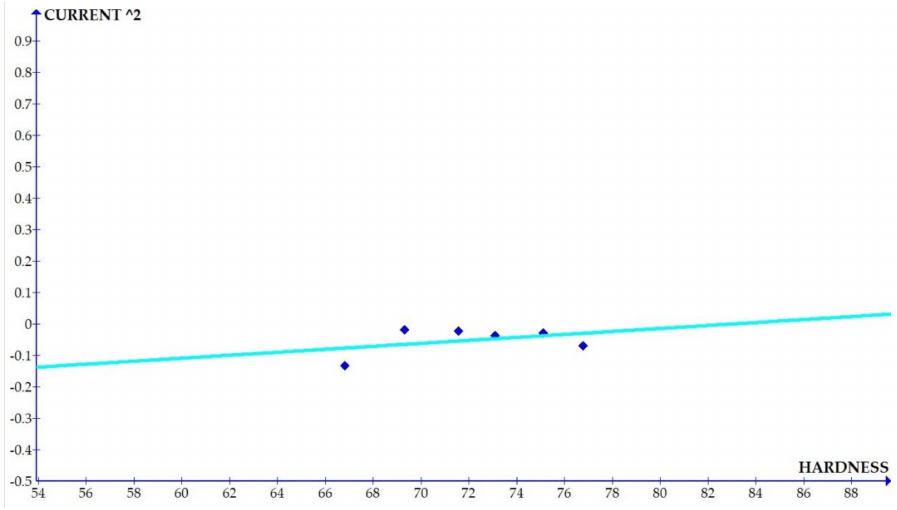
Figure 16. Coefficient of surface roughness: current 2 vs.